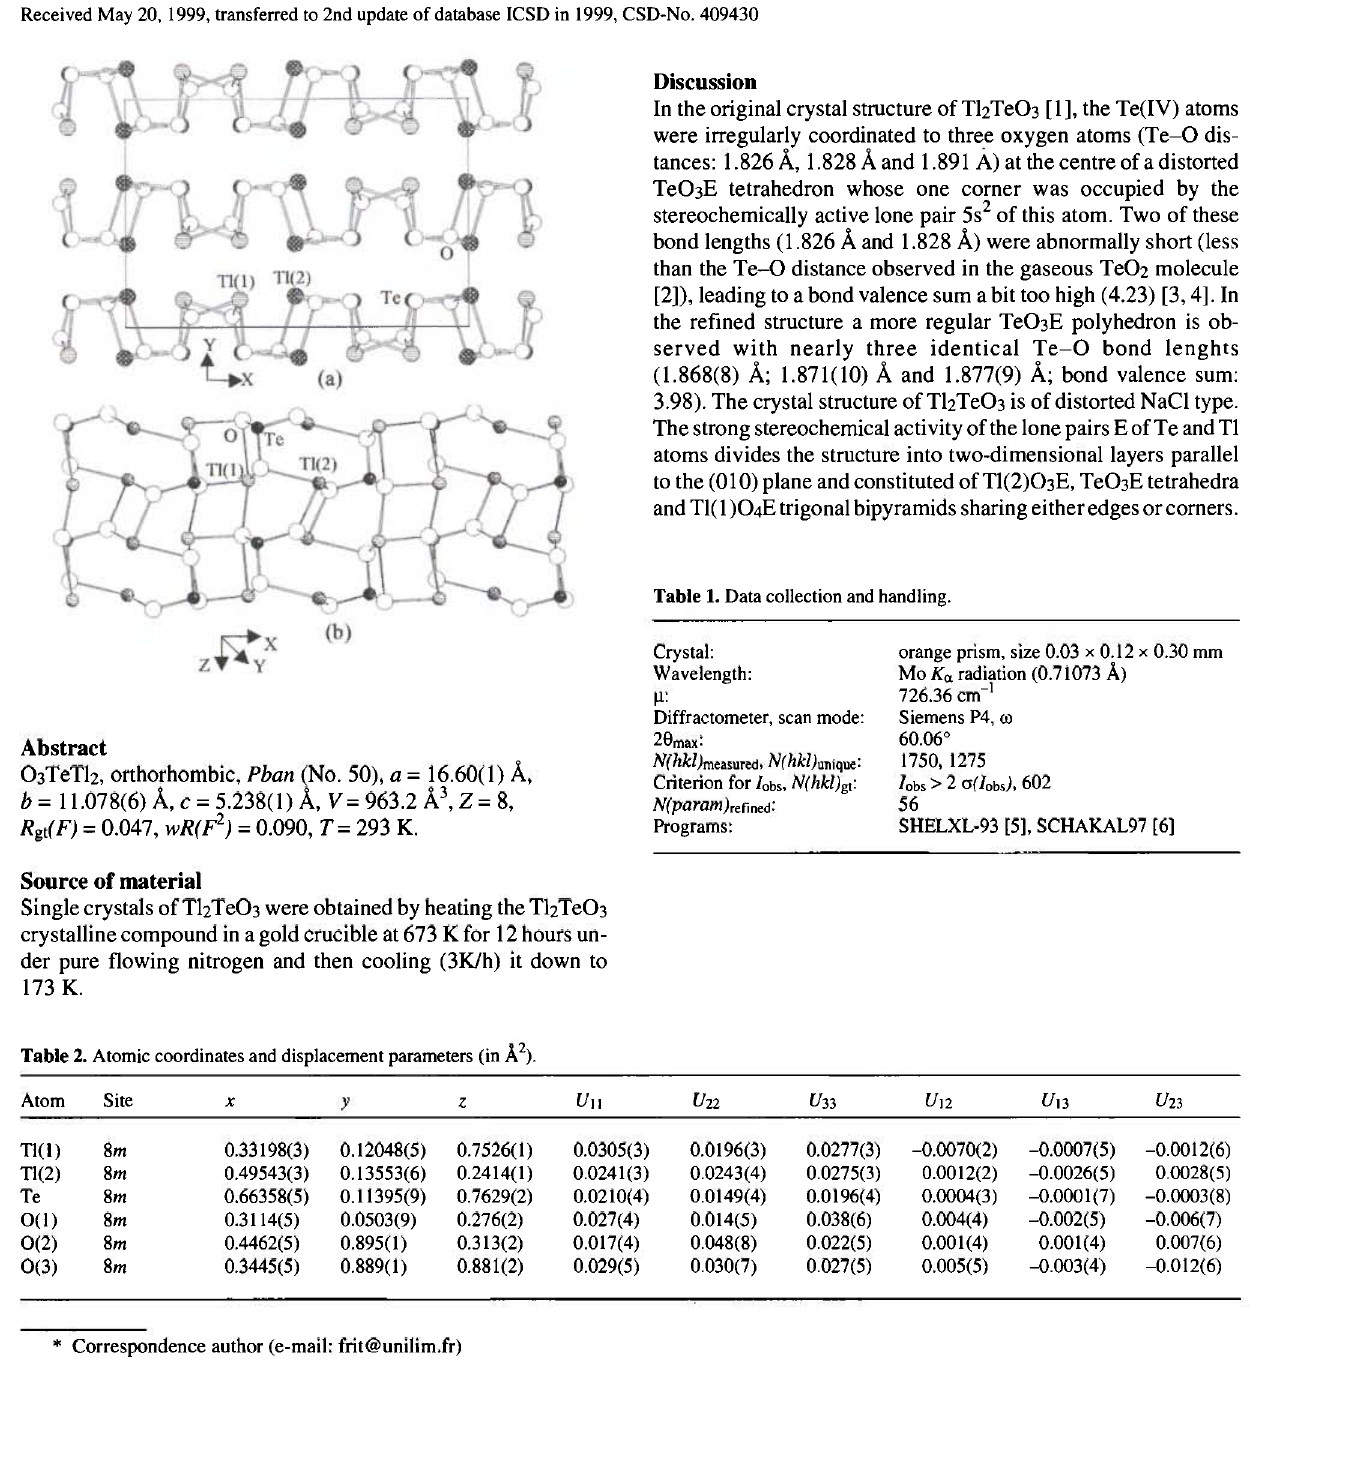
Table 2. Atomic coordinates and displacement parameters (in Ä 2